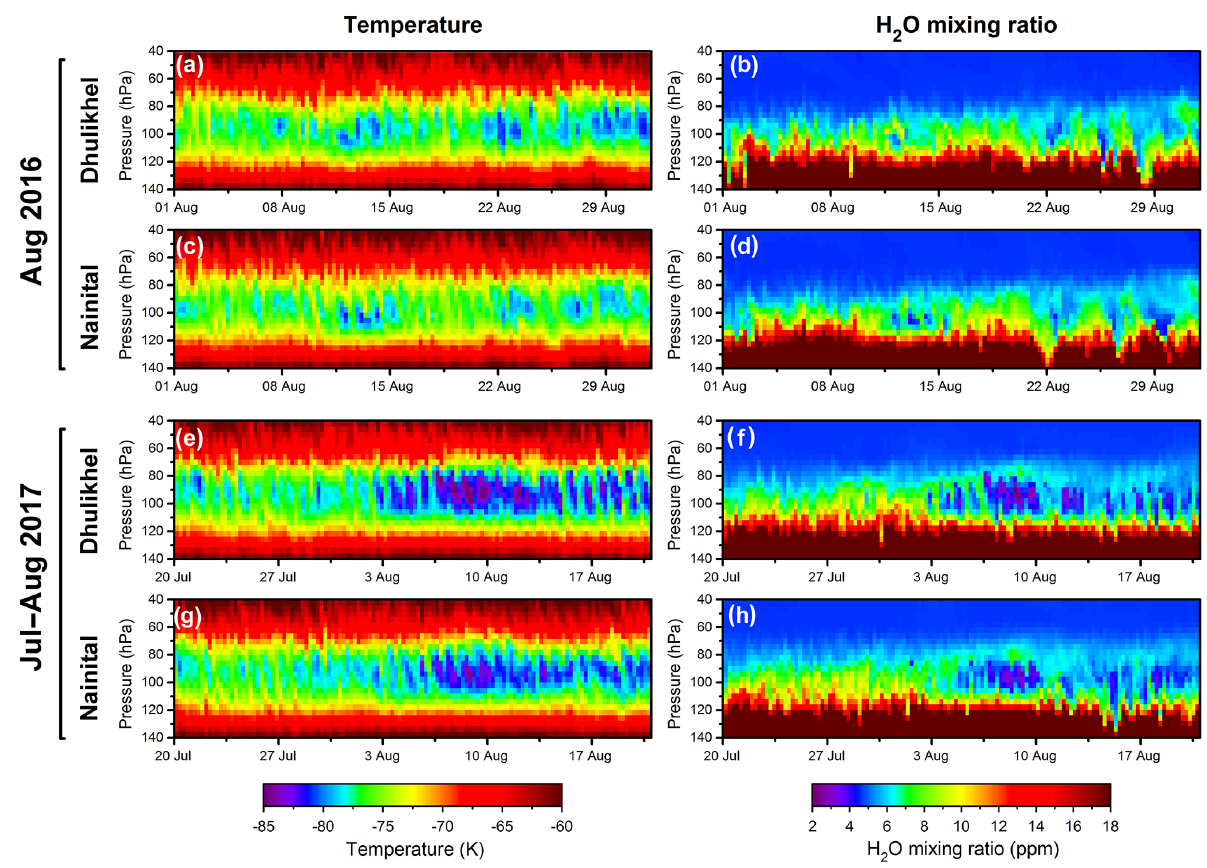
Figure 3. Time series of temperature (a, c, e, g) and the water vapor mixing ratio (b, d, f, h) as a function of pressure, from ECMWF operational analysis data (6-hourly, same horizontal and vertical resolution as given in the caption of Fig. 2) for NT (c, d, g, h) and DK (a, b, e, f) from 1 to 31 August 2016 (a–d) and from 20 July to 21 August 2017 (e–h)